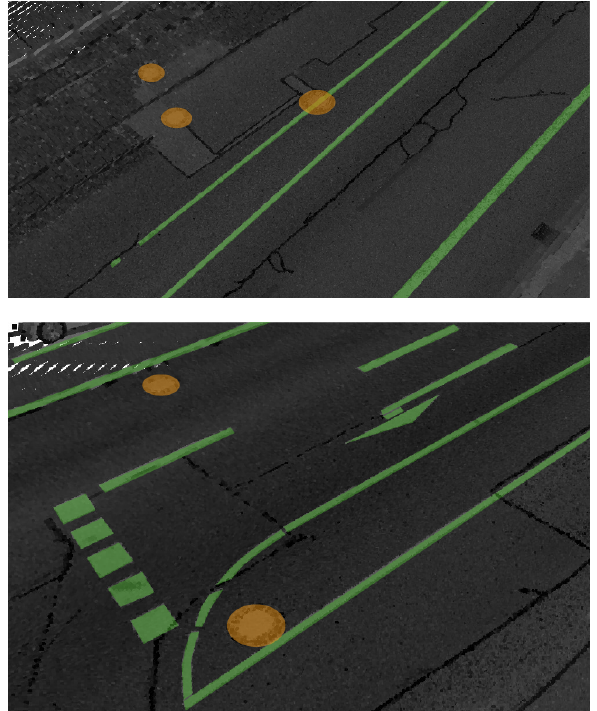
Figure 3. Point clouds with detected manhole covers (orange) and road markings (green) represented as shapes rendered on top of the point cloud.